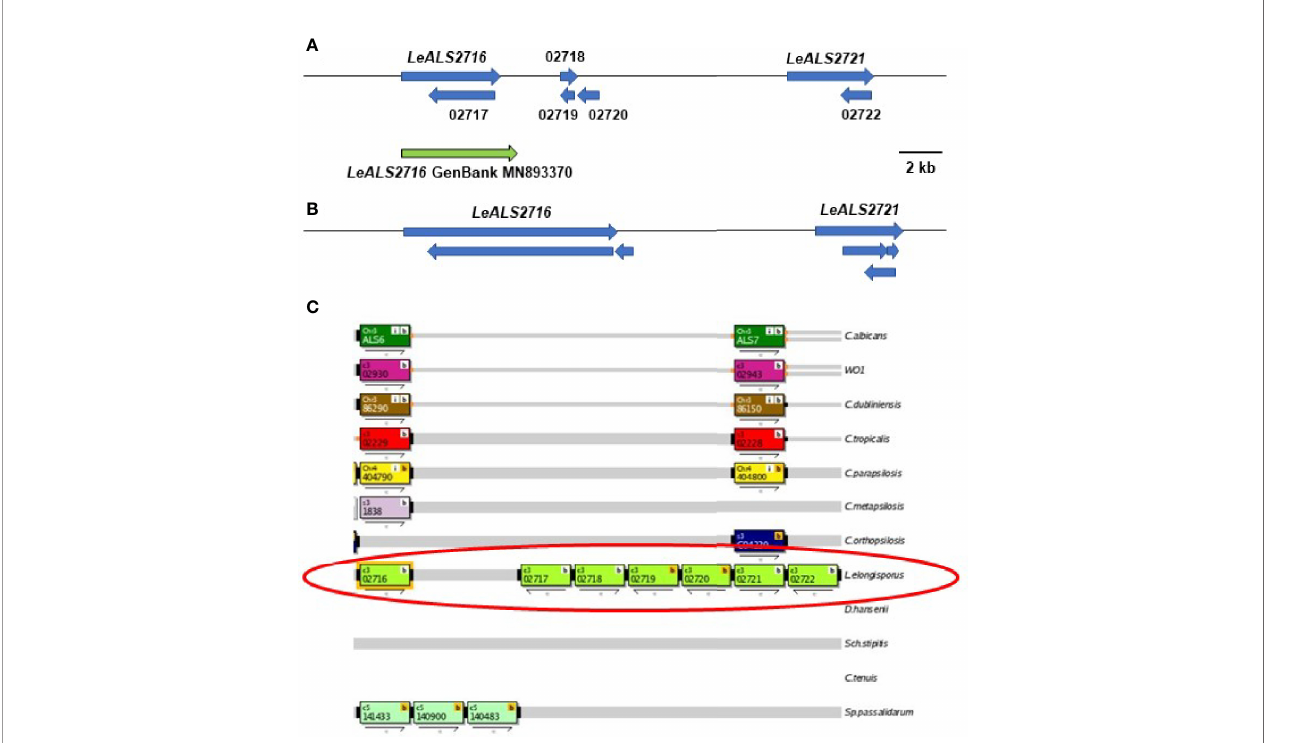
FIGURE 2 | Schematic of the genome region that included LeALS2716 and LeALS2721 from (A) assembly ASM14968v1 and (B) assembly ASM1362098v1. (C) shows the region as represented in the Candida Genome Order Browser (CGOB; https://cgob.ucd.ie; Maguire et al., 2013) based on ASM14968v1 data. L. elongisporus information is circled in red; ORF numbers are shown in each rectangle and the direction of transcription indicated by the arrow below. ORFs 02718, 02719, and 02720 featured the IFF/HYR repeated sequences that were also found in LeALS2716 suggesting that ORF 02716 was longer than initially annotated. The large number of repeated sequences complicated genome sequence assembly in this region. The predicted size of LeALS2716 in ASM1362098v1 was greater than the fi nal PCR-ampli fi ed/Sanger-sequenced fragment that was deposited into GenBank (accession number MN893370; green